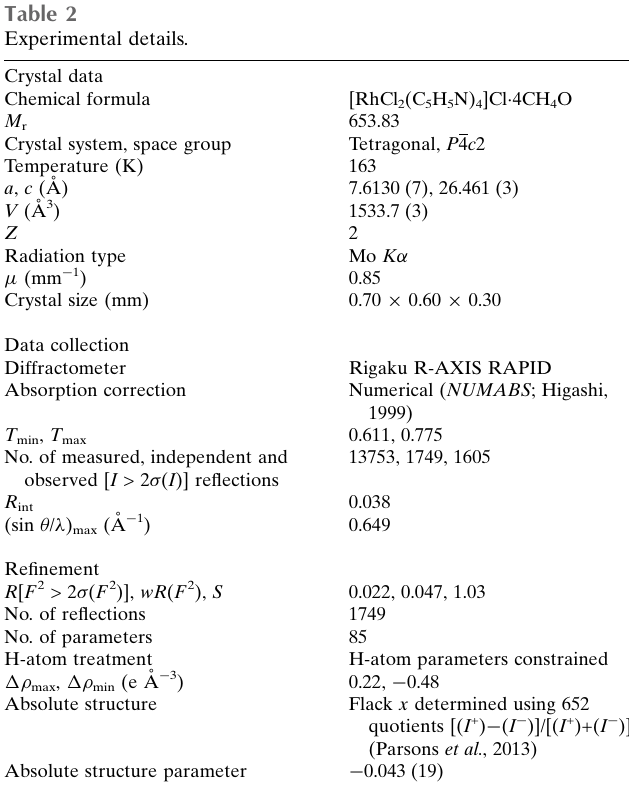
Table 2 Experimental details.